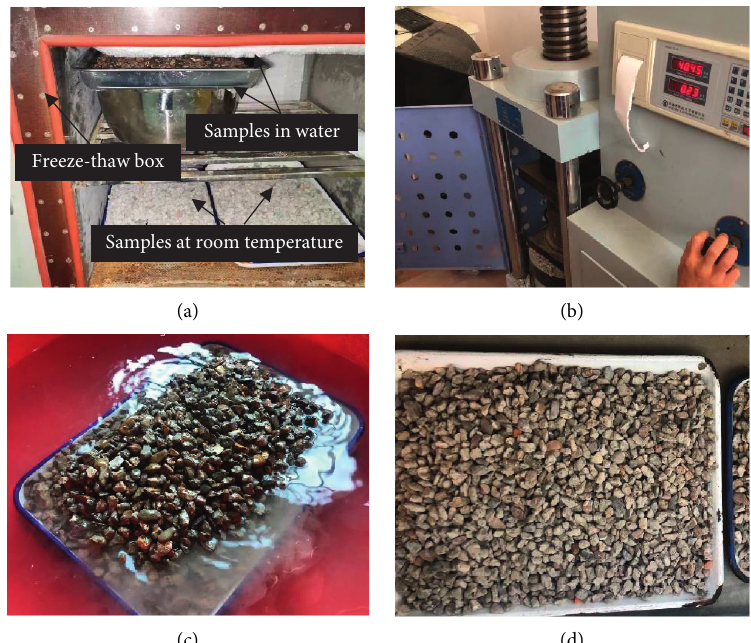
Figure 6: Crushing value test under freeze-thaw cycle: (a) sample in the freeze-thaw box; (b) crushing value test; (c) samples melted in water; (d) samples melted at room temperature.